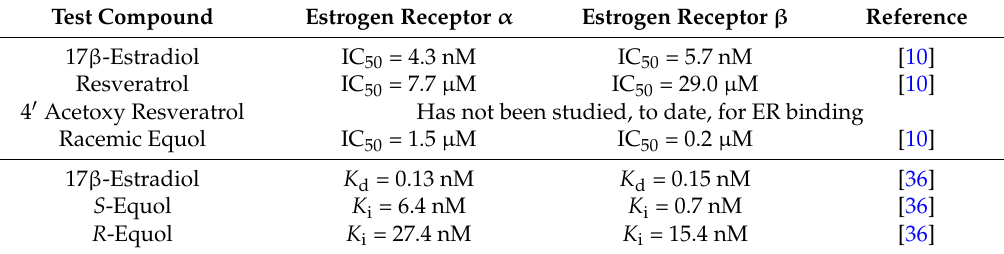
Table 1. Estrogen receptor (ER α and ER β ) binding characteristics of 17 β -estradiol compared to resveratrol, 4 (cid:48) acetoxy resveratrol, racemic equol, S -equol and R -equol. 17 β -estradiol has very